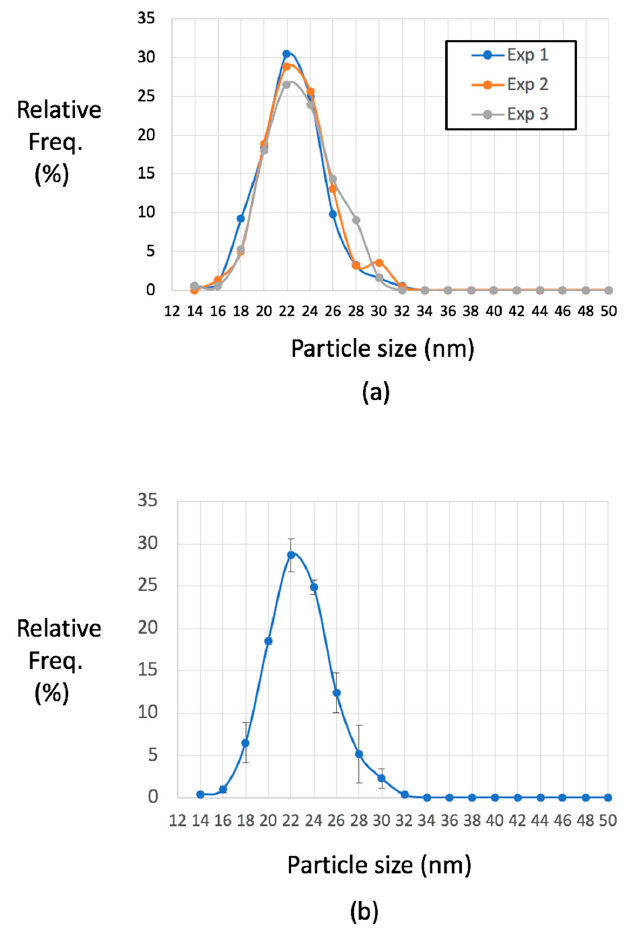
Figure 2. Reproducibility of particle analysis from a purified LDL preparation. In ( a ), three samples from the same LDL preparation were processed using the standard mixed metal MC and horizontal calliper distance measured in 185, 222, and 188 particles. ( b ) Means +/ − SD (x axis labels refer to lower limit of 2-nm bins). No significant difference between these distributions with means 23.41, 23.82, 24.00; Kruskal-Wallis test statistic H = 5.778, df 2, p = 0.056. Data are expressed as the relative frequency of particle number for each particle size category expressed as a percentage of total particles analyzed (Relative Freq. %).